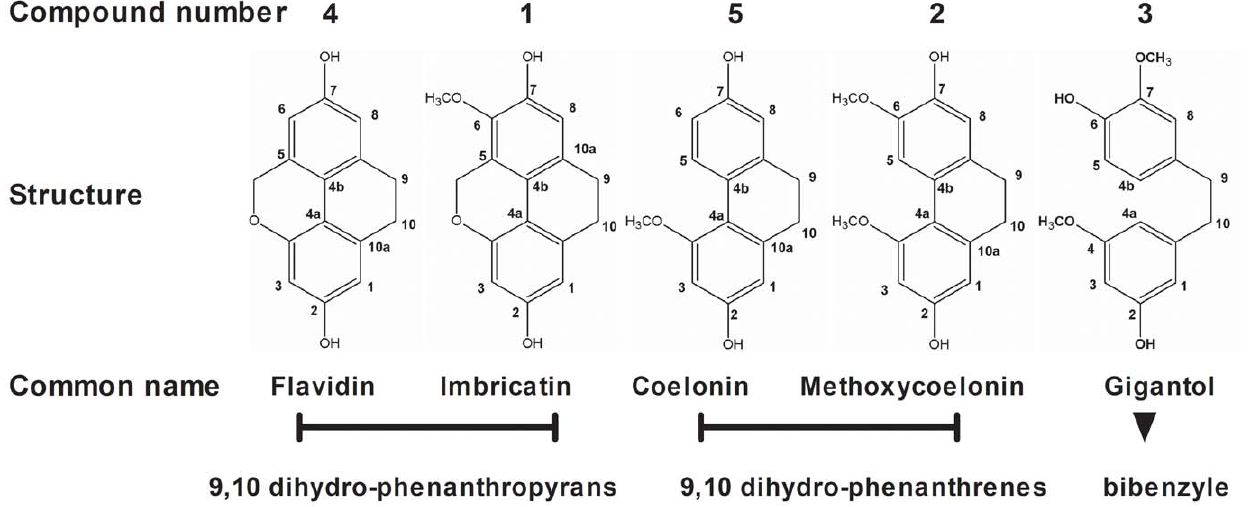
Figure 1. Structures of stilbenoids isolated from V. coerulea stems. Stilbenoids isolated from Vanda coerulea stems belong to the phenanthrene group including 9,10 dihydro-phenanthrenes, 9,10 dihydro-phenanthropyrans and bibenzyles. Carbone numbering relative to NMR data is represented here. Compounds 1 and 4 are 9,10 dihydro-phenanthropyrans, compounds 2 and 5 are 9,10 dihydro-phenanthrenes and compound 3 is a bibenzyle.